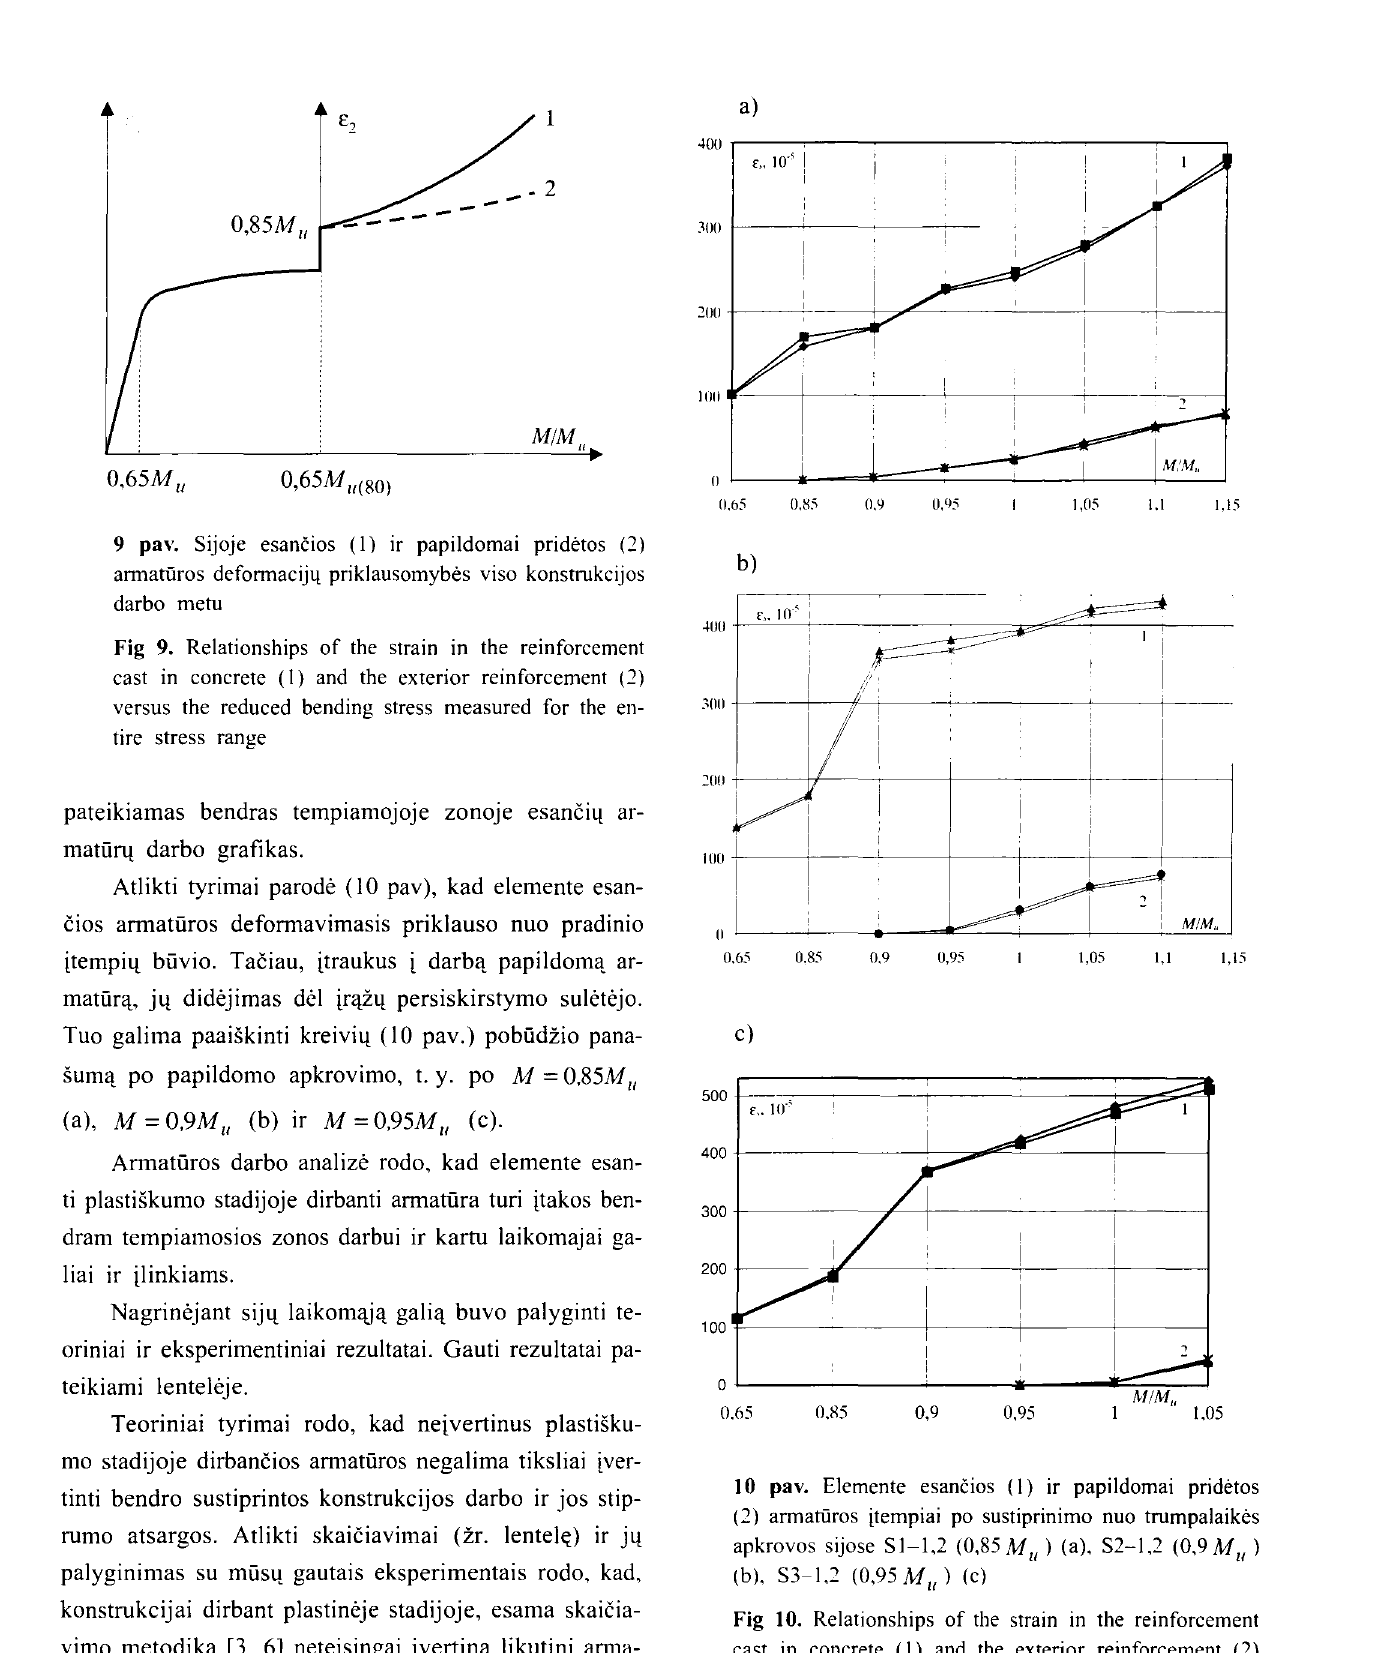
Fig 9. Relationships of the strain in the reinforcement cast in concrete (I) and the exterior reinforcement (2) versus the reduced bending stress measured for the en tire stress range